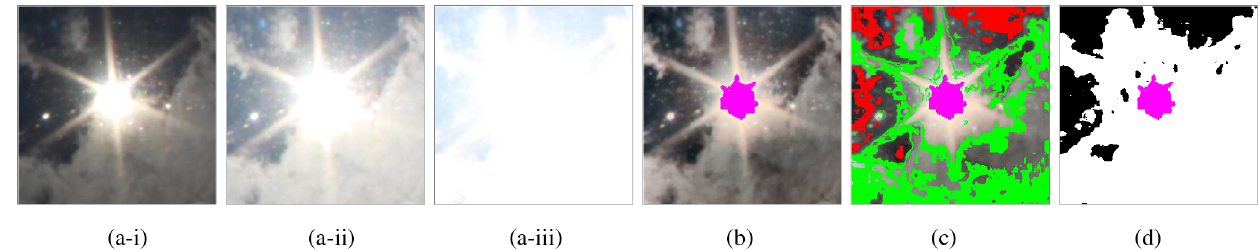
Figure 4. Proposed HDRCloudSeg framework for sky–cloud segmentation. (a) Exposure bracketed low-dynamic-range (LDR) images; (b) high-dynamic-range (HDR) image tone-mapped for visualization purpose; (c) image with initial seeds, where cloud seeds and sky seeds are represented in green and red , respectively; (d) binary sky–cloud segmentation result. The saturated pixels in panels (b–d) are masked in pink.